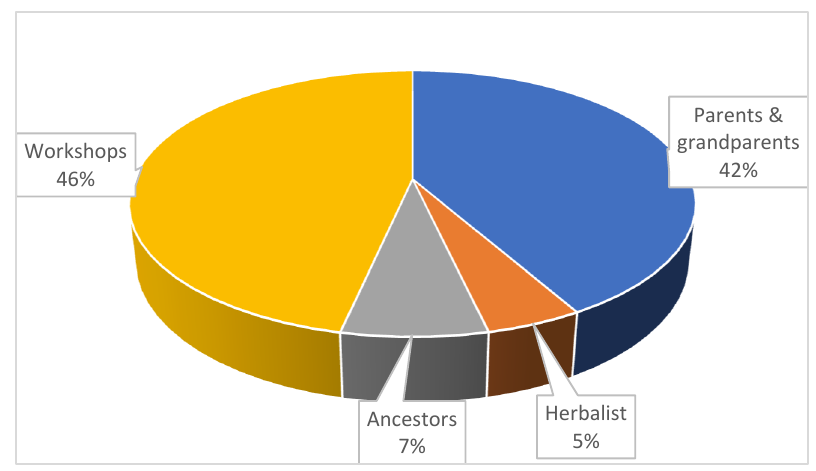
Figure 1. Distribution of the sources of indigenous knowledge among subsistence farmers who use medicinal plants for mitigating cabbage and spinach diseases in OR Tambo Municipality, South Africa, (n = 41).